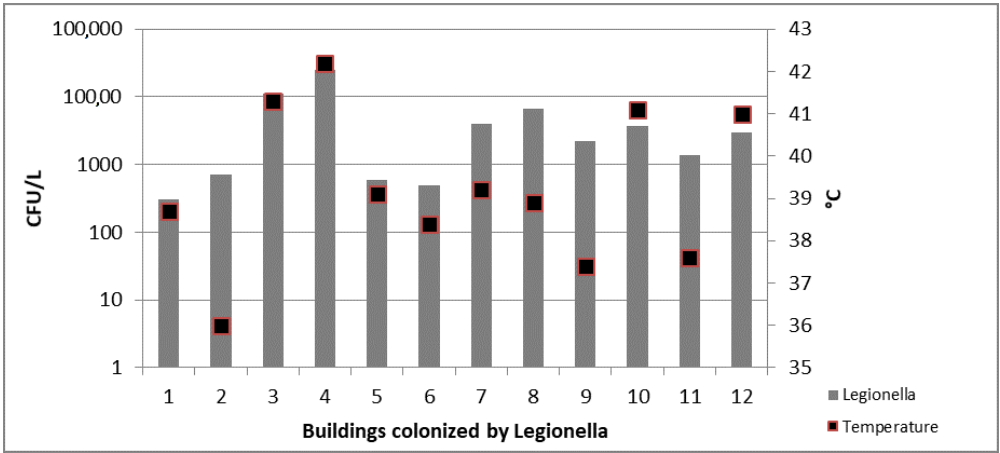
Figure 4. Legionella counts and temperature values detected in 12 colonized TB.